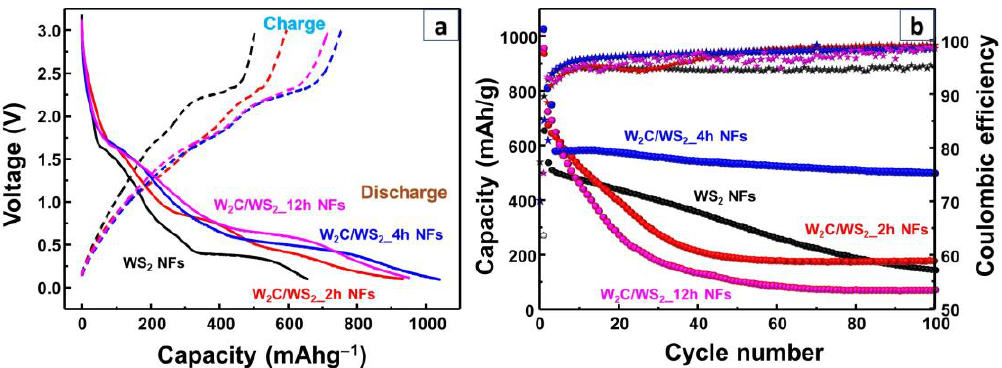
Figure 6. ( a ) Initial voltage profiles and ( b ) cyclic performance of the as-prepared WS 2 NF, W 2 C / WS 2 _2h NF, W 2 C / WS 2 _4h NF, and W 2 C / WS 2 _12h NF electrodes over 100 cycles.